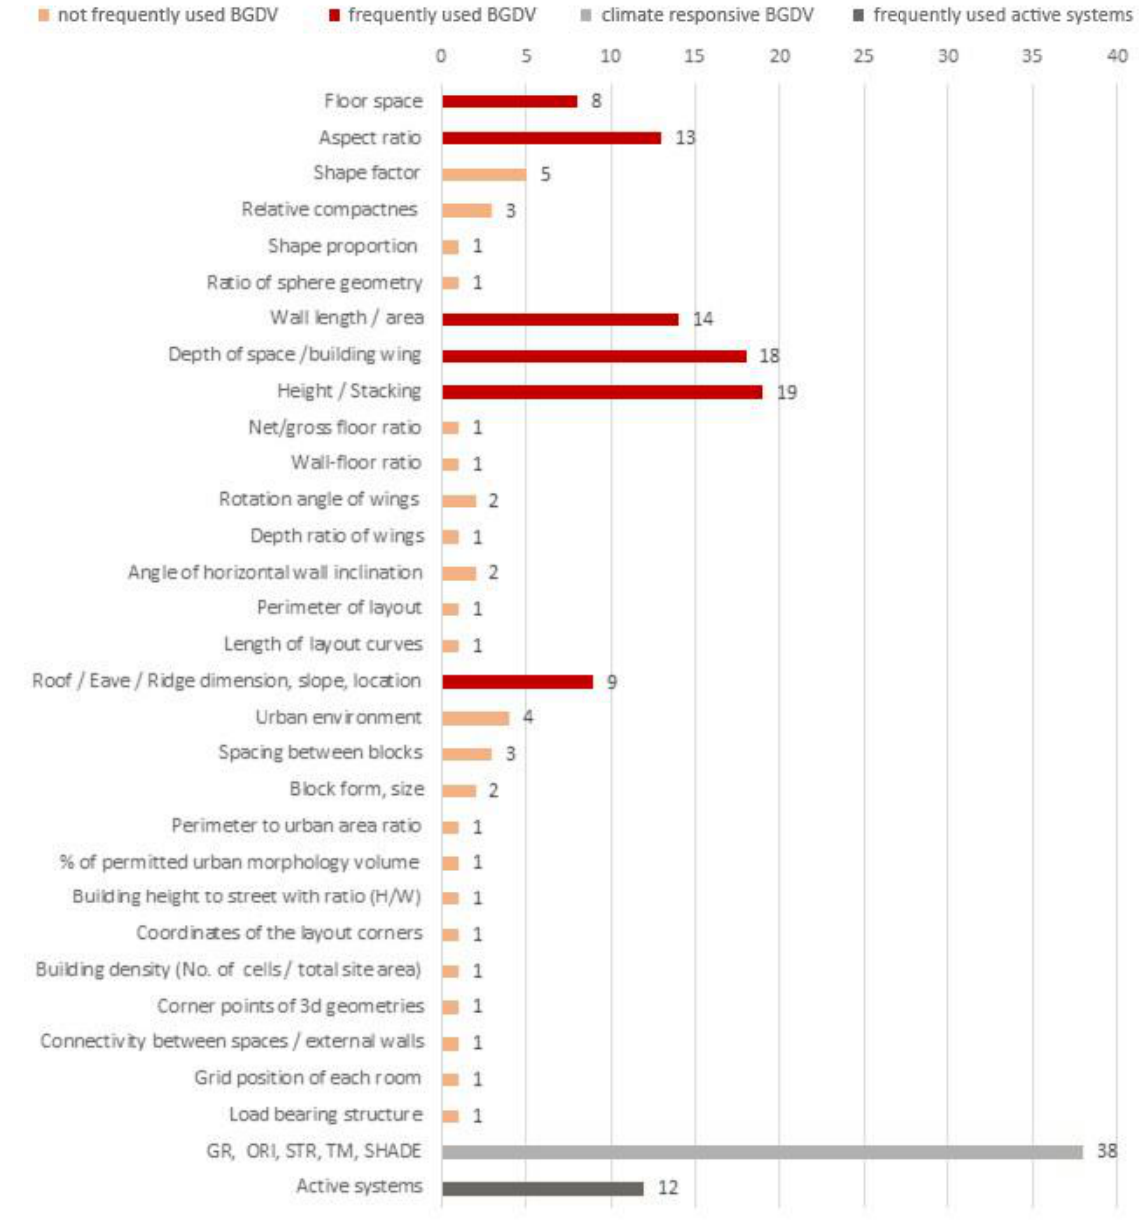
Figure 2. Number of publications (1987–2021) applying BGDVs in BECEDO research. The most frequent used BGDVs (red bar in Figure 2) together with the energy efficiency related BGDVs (shape factor and relative compactness) are assessed in chronological order in Figure 3 and Table 3 to display trends in the application frequency of the shape variables in BECEDO-s. From 2020, the number of BGDV applications is